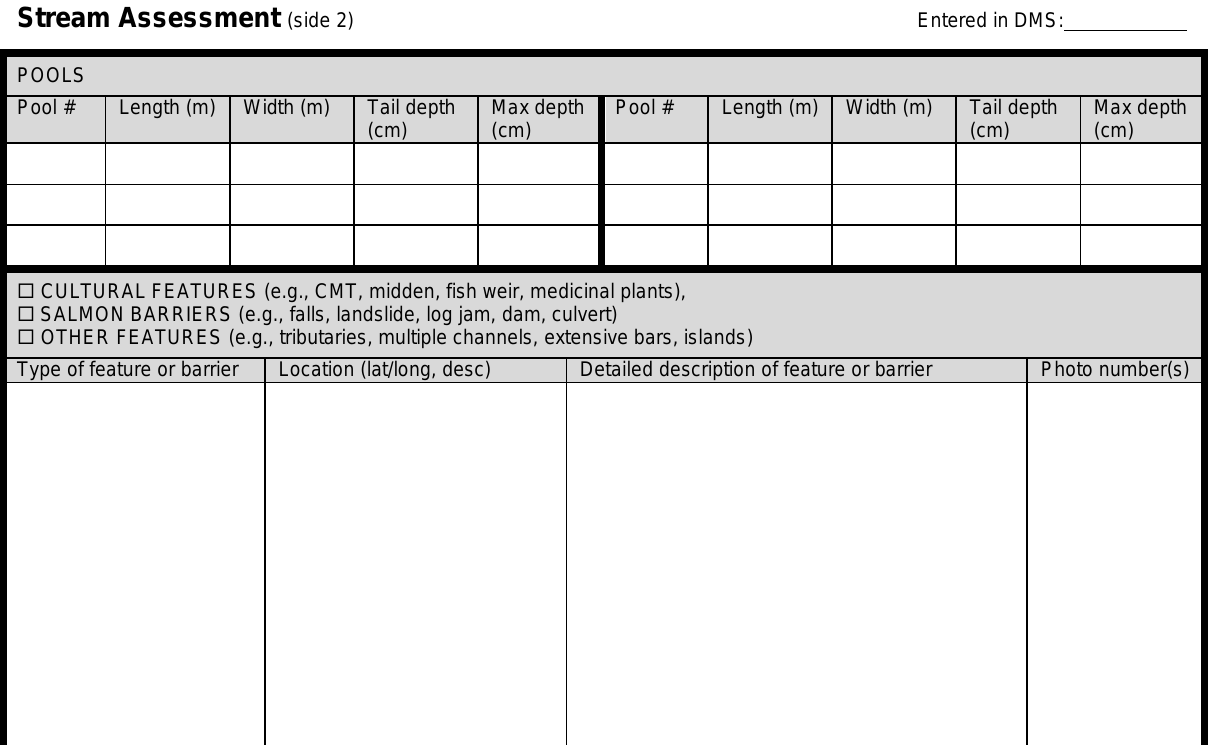
Fig. A1.3 – Side 2 of the Stream Assessment